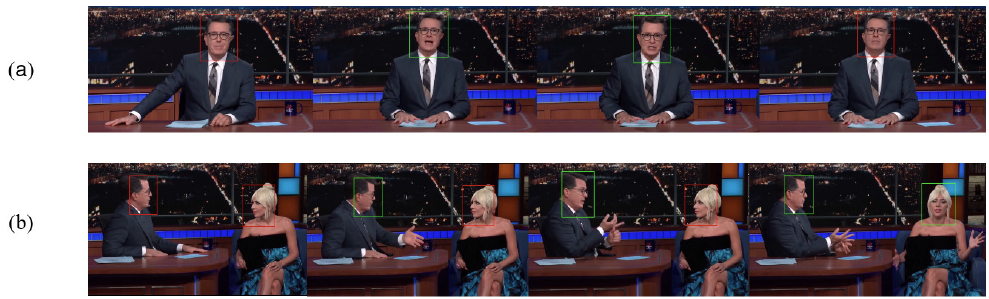
Figure 4. Performance of the trained full model on unseen data: ( a ) Single speaker scenario. ( b ) Multiple speaker